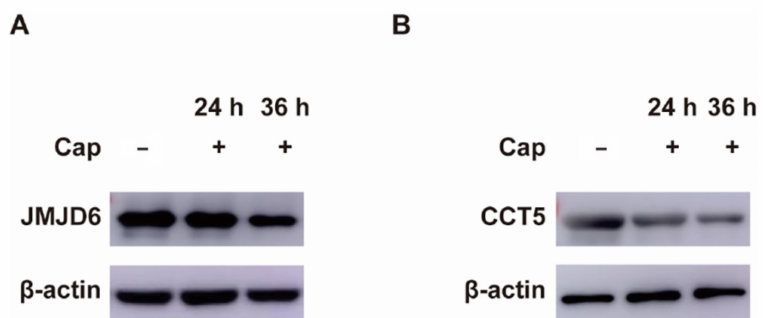
Figure 4. We validated the PCV2 Cap down-regulated host proteins by Western blotting (WB). ( A ) The expression of JMJD6 in PK-15 cells was determined by WB analysis. ( B ) The expression of CCT5 in PK-15 cells was determined by WB